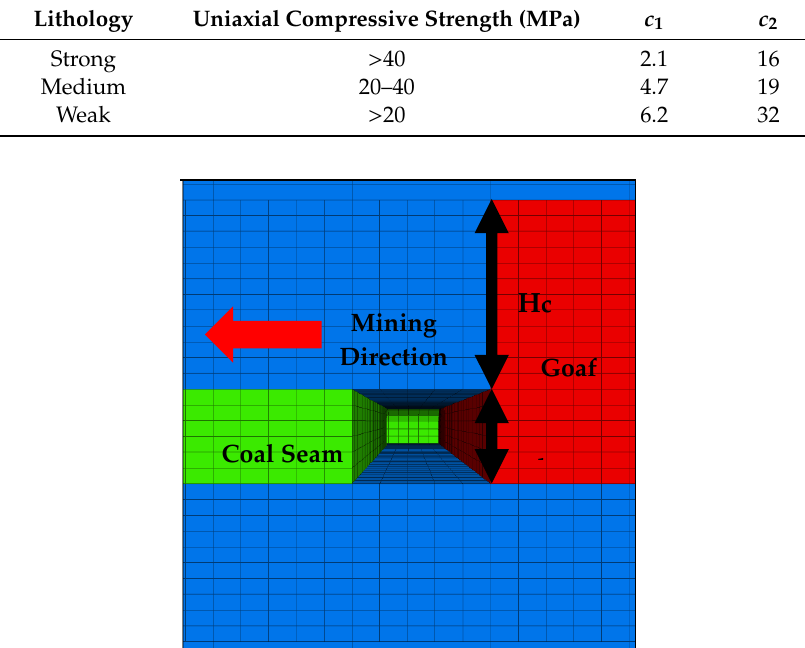
Table 3. Lithology coefficients.